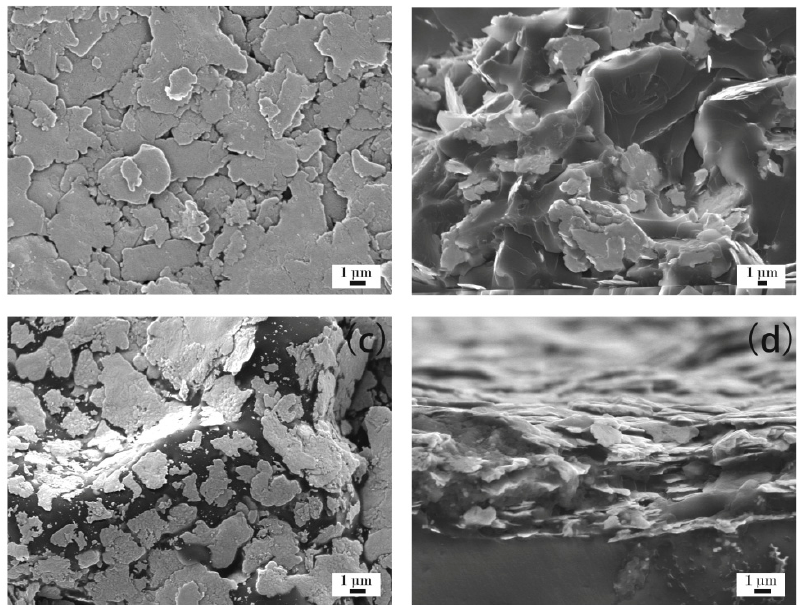
Figure 5. ECAs filled with 30 wt % Ag flakes. ( a ) ECAs fabricated by the powder spraying process; and ( b ) cross sections of ECAs fabricated by the powder spraying process; ( c ) ECAs fabricated by the conventional process; and ( d ) cross sections of ECAs fabricated by the conventional process.